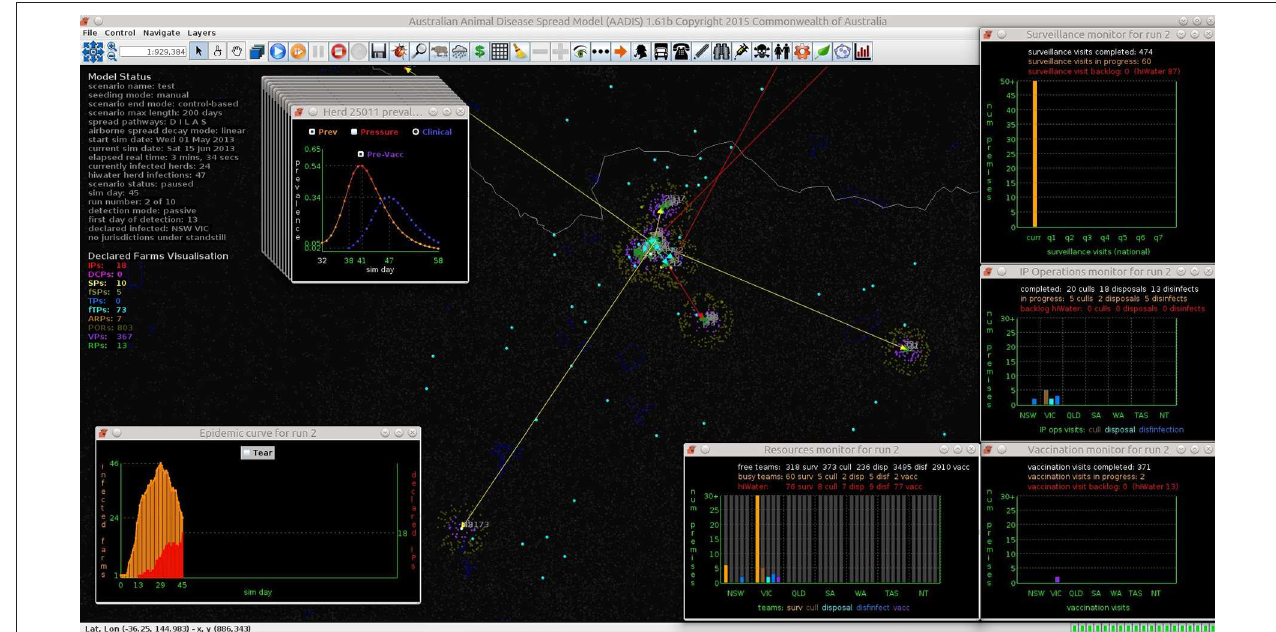
FIGURE 5 | Dynamic visualization of outbreak